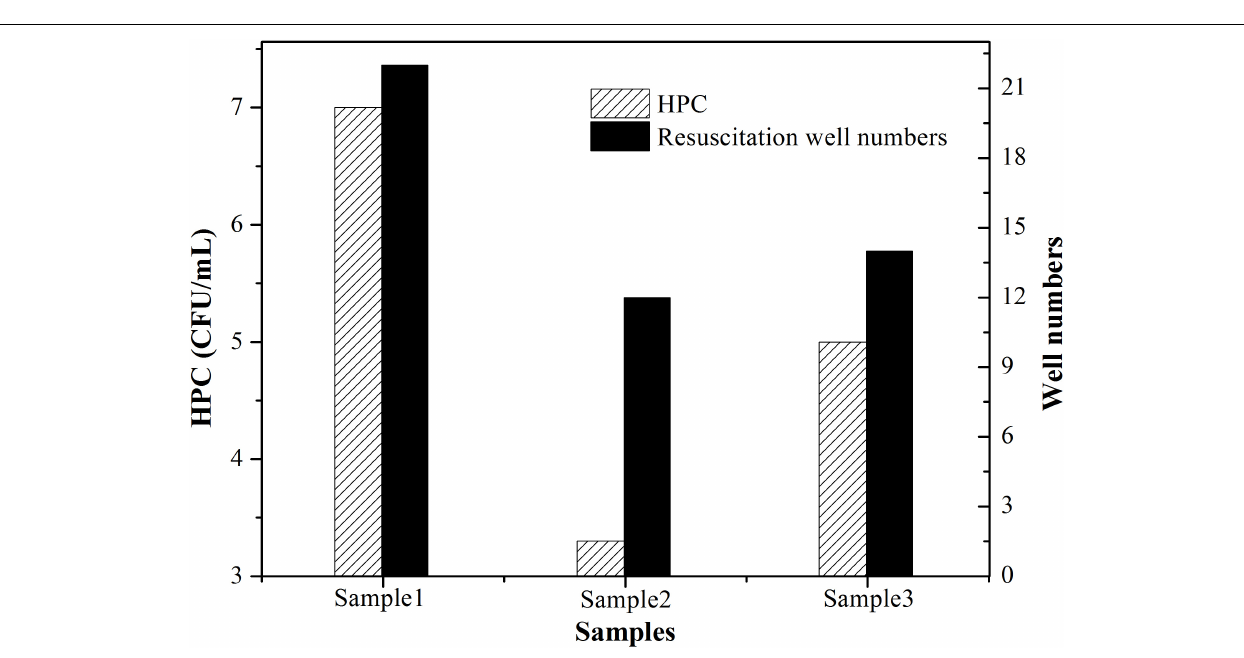
FIGURE 4 | Resuscitation identified in simulated reclaimed water (SRW) after treatment by 41 mJ cm - 2 UVC. One hundred of 1.5 mL centrifuge tubes containing UVC-treated bacteria solution and LB medium were incubated at 37 ◦ C overnight in triplicate. Patterned column denoted as ‘HPC’ represents number of culturable cells determined by HPC; black column denoted as ‘Resuscitation tube numbers’ represents the number of tubes that became visibly turbid.